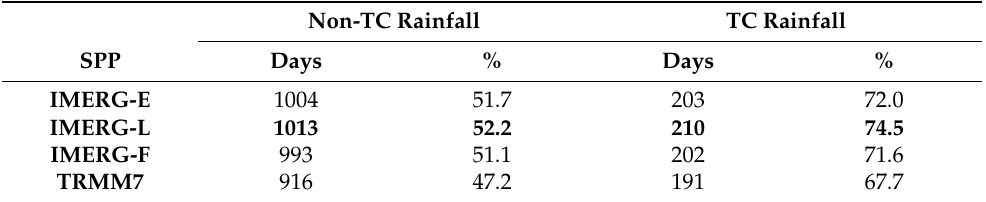
Table 4. Accumulated number and percentage (%) of days in Figure 4 with Scorr values ≥ 0.5. Highest values are bold.